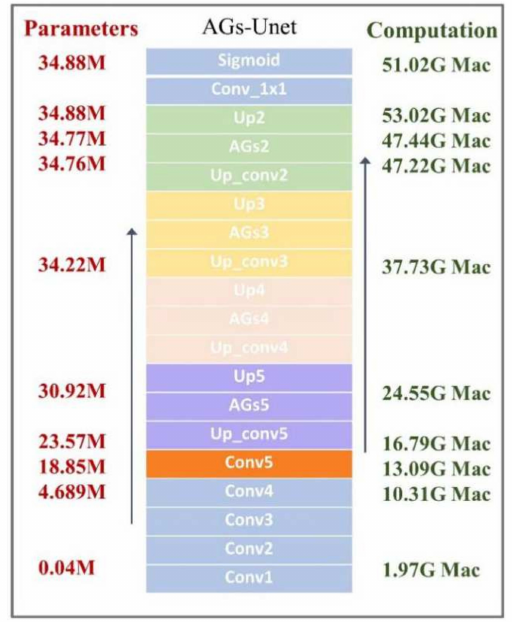
Figure 9. Statistics of structural parameters and calculations for